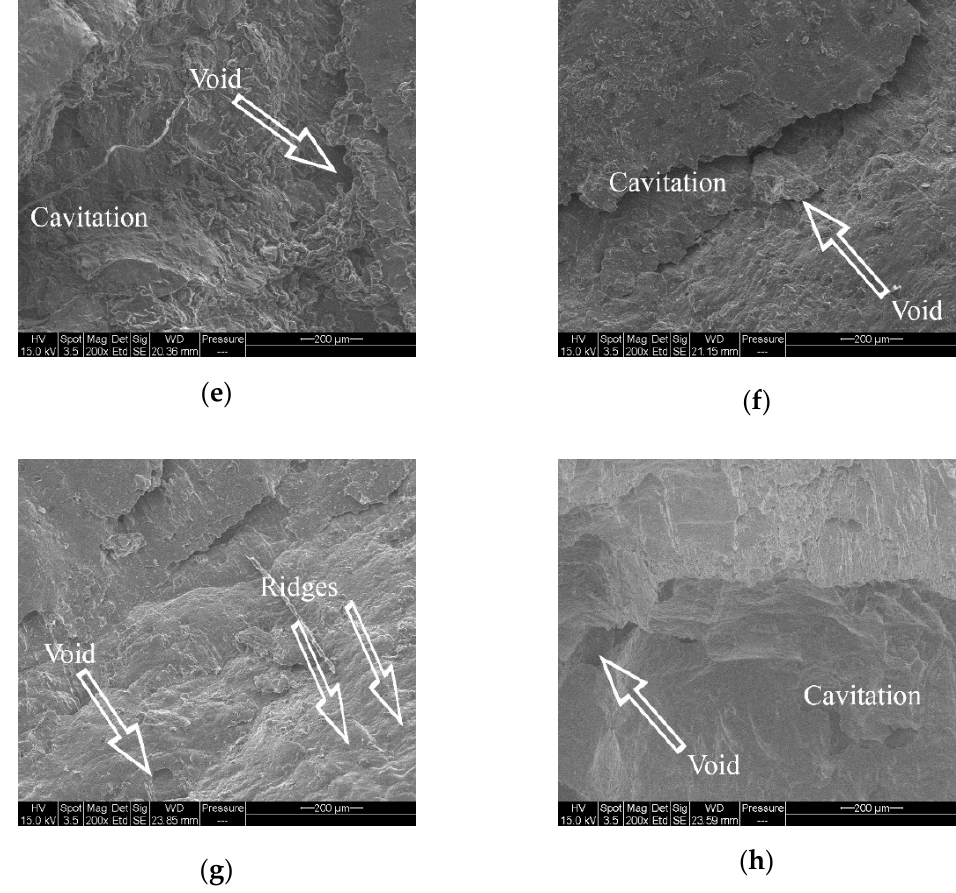
Figure 8. SEM images for the fractured tensile specimens: ( a ) commercial purity Al, ( b ) Al-0.02Zr, ( c ) Al-0.04Zr, ( d ) Al- 0.06Zr, ( e ) Al-0.08Zr, ( f ) Al-0.10Zr, ( g ) Al-0.12Zr and ( h ) Al-0.14Zr.